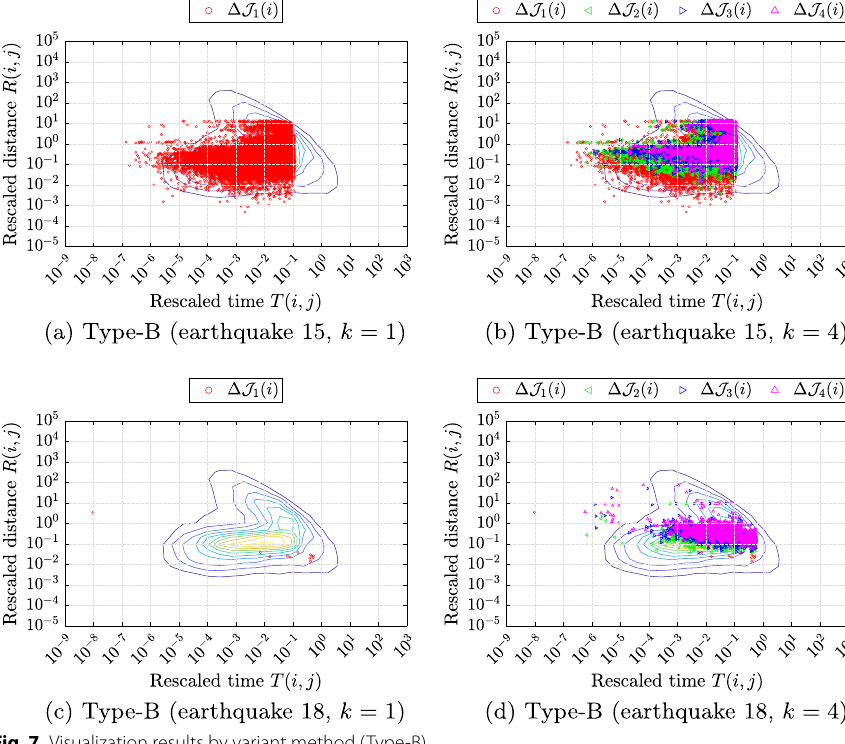
Fig. 7 Visualization results by variant method (Type-B)